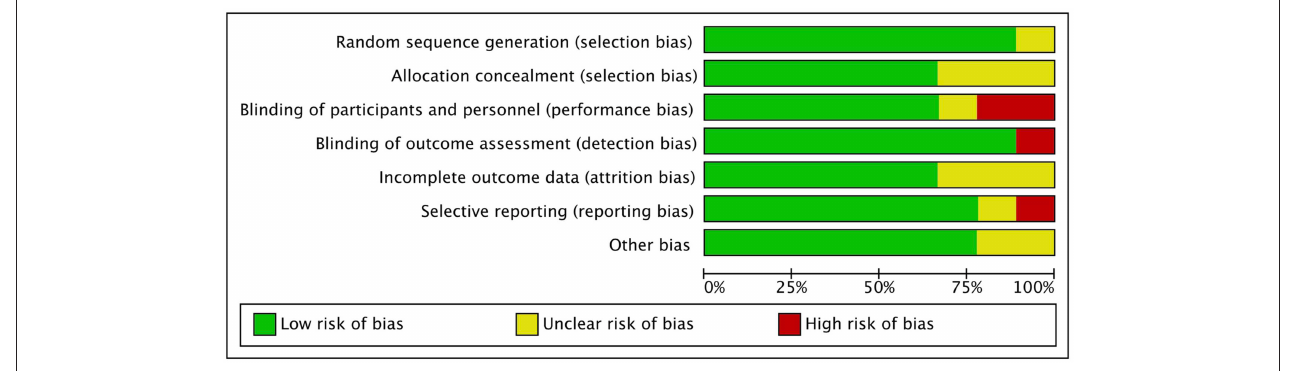
FIGURE 2 | Risk of bias